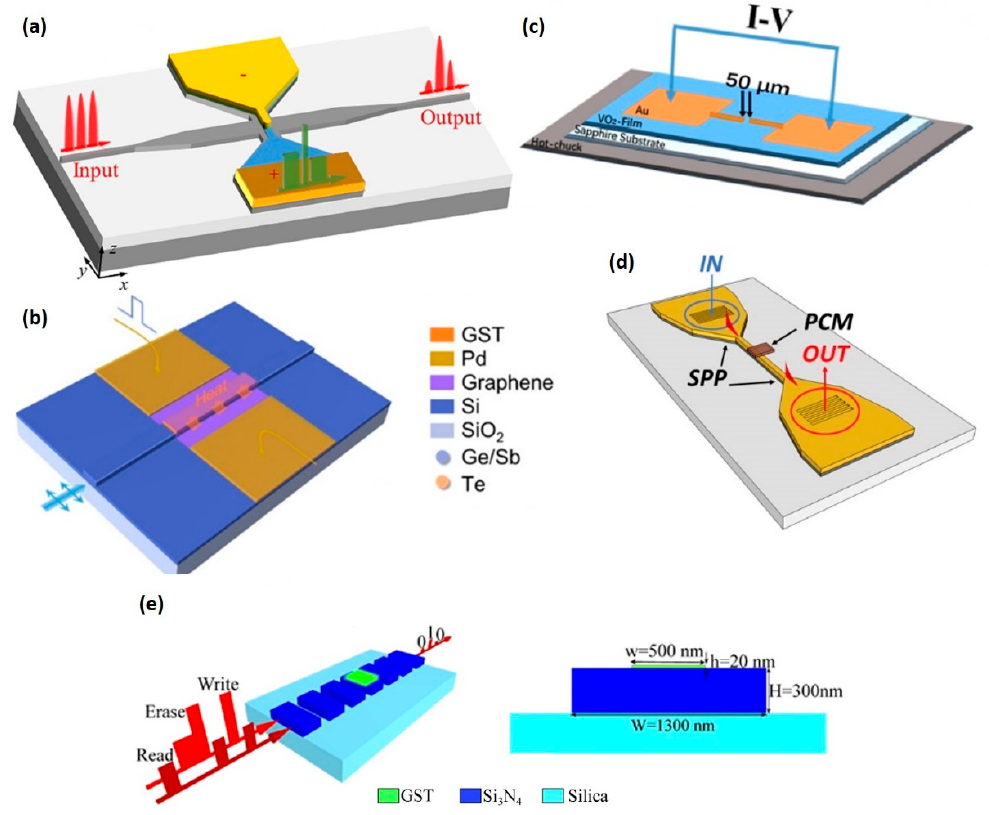
Figure 6. Various electrical and optical switching methods. ( a ) Electrical switching of GST on silicon waveguide using Au electrodes [91]. ( b ) Electrical switching of GST using Pd electrodes while using a graphene heater (reproduced with permission [92]). ( c ) Schematic of VO 2 devices for electric field-driven metal-to-insulator transition (reproduced with permission [93]). ( d ) Schematic of PCM heating through control of surface plasmons polaritons with external